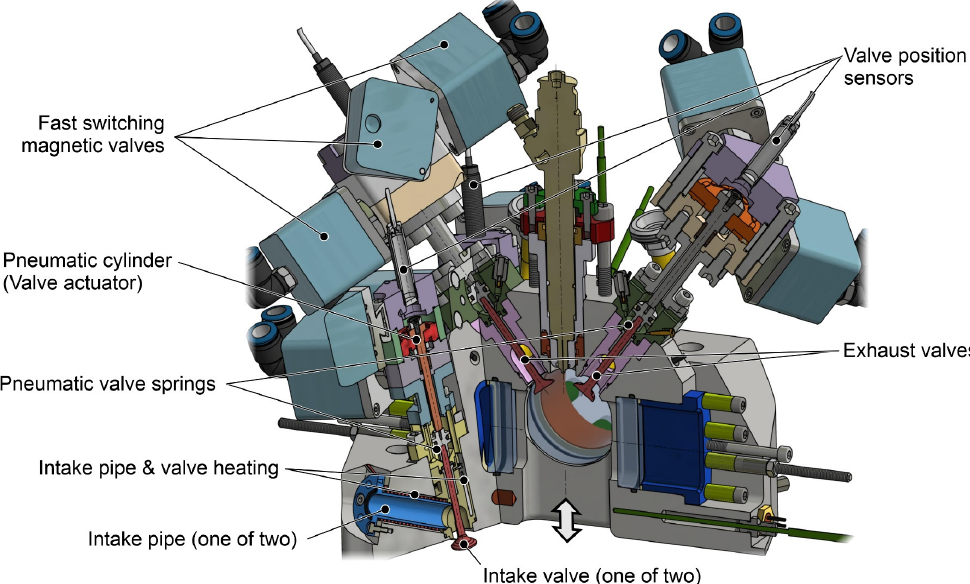
Figure 6. The pneumatically operated intake and exhaust valves. Multiple, fast switching pneumatic valves are used for each cylinder to open and close the gas exchange valves as quickly as possible.